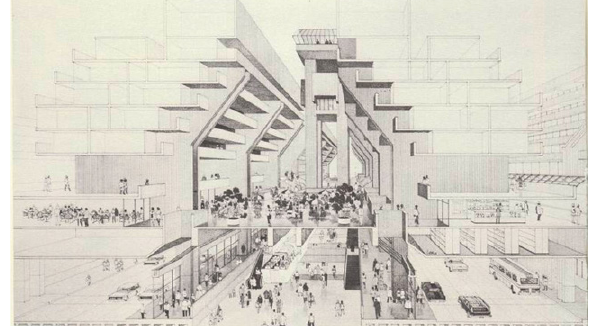
Figure 12. Project for the Terminal Building at DFW Airport, (1966). Published by Walther Prokosch in Detailed Design (1983). The section is clearly related to the Smithson drawings, especially Airport Site Map